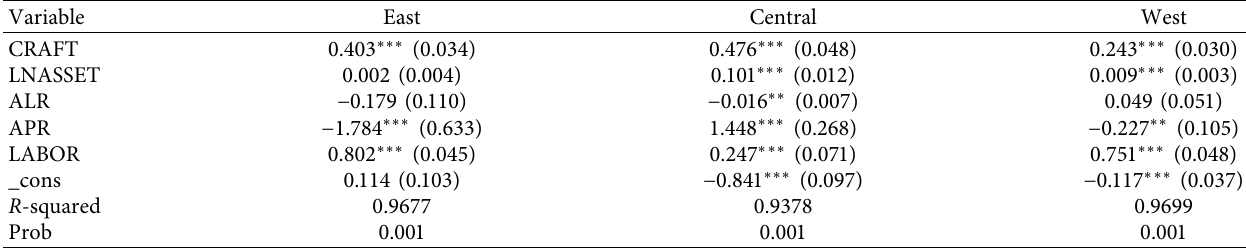
Table 8: Comparison of empirical test results in different